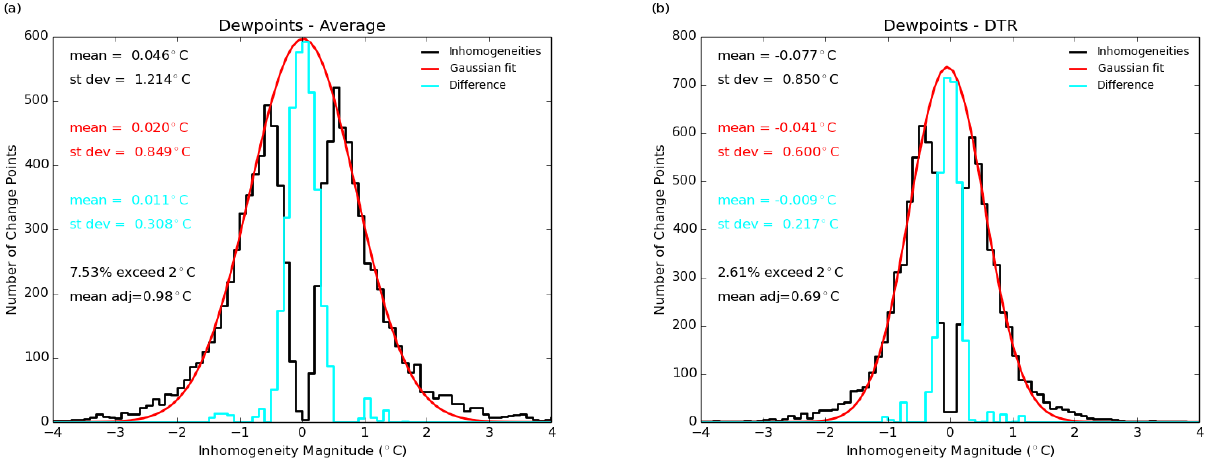
Figure 7. The distribution of the inhomogeneity magnitudes for monthly-mean (a) dew point temperatures and (b) diurnal dew point temperature range. The distributions have been fitted with a Gaussian (red), and the difference between the data and the Gaussian is shown in blue.